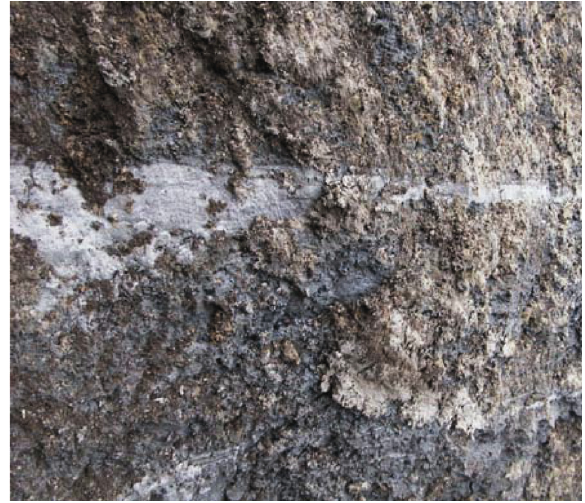
Fig. 3. Illustration of the layering in the soil in Grindsted